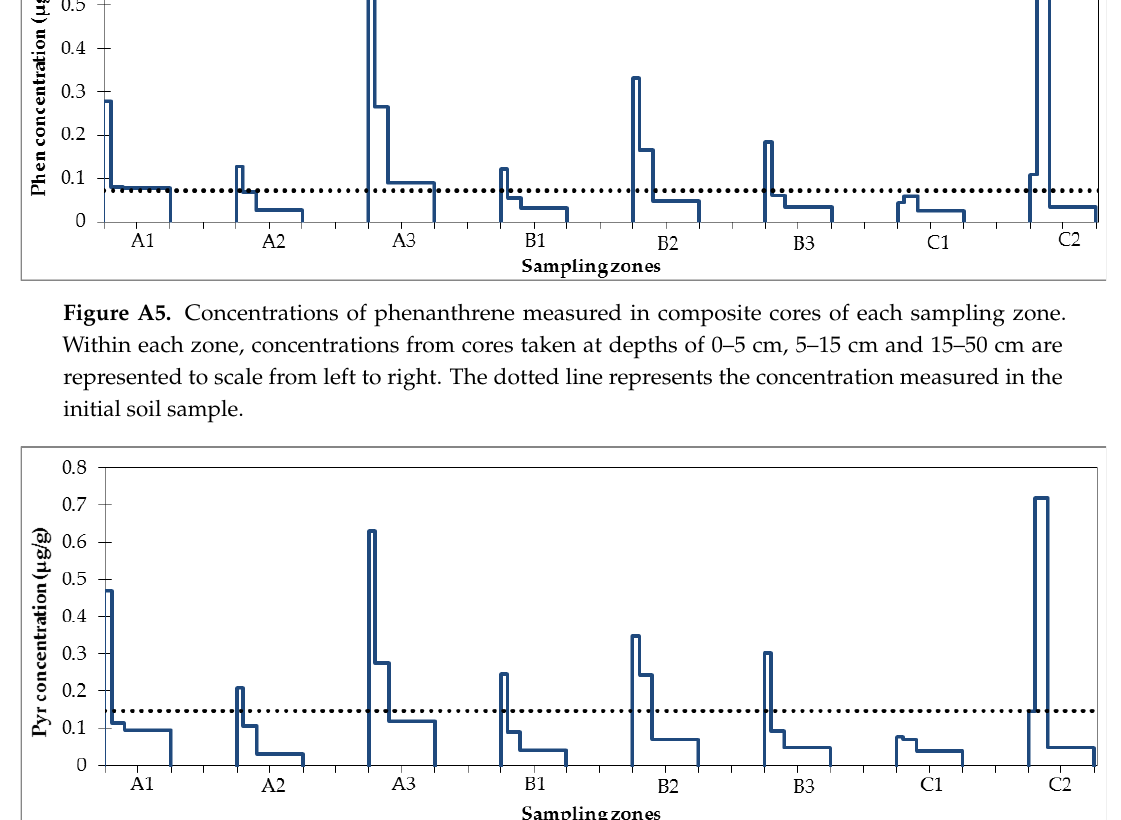
Figure A6. Concentrations of pyrene measured in composite cores of each sampling zone. Within each zone, concentrations from cores taken at depths of 0–5 cm, 5–15 cm and 15–50 cm are represented to scale from left to right. The dotted line represents the concentration measured in the initial soil sample.